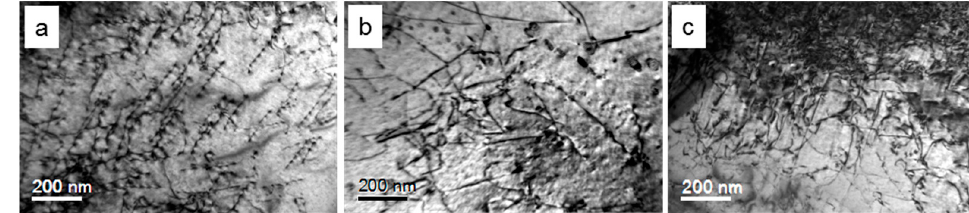
Figure 8. Selected TEM bright field images of dislocation substructure in ferrite after 15 min simulated coiling: ( a ) HFT/600, ( b ) HFT/650 and ( c ) LFT/600.